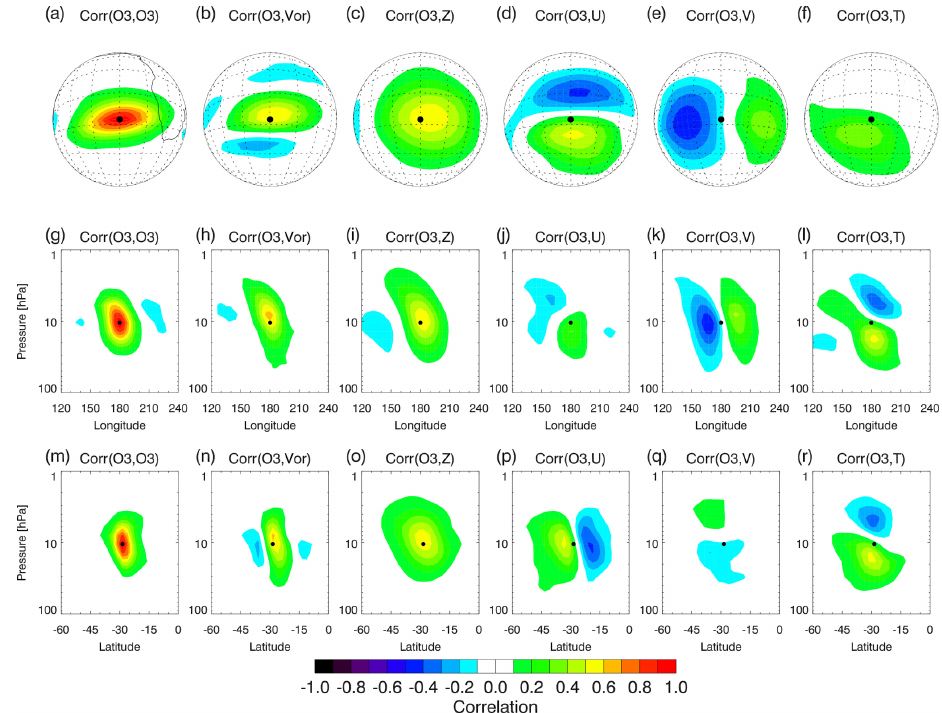
Figure 12. Composite analysis of the ensemble cross-correlations (“Corr”) between ozone and other variables on 30 November 2014 (00:00Z). Calculation is an average at 10.5hPa and latitude of 28.6 ◦ S, and the observation (black dot) is centered at 180 ◦ longitude (see text for details). Top row is the horizontal correlation using a satellite projection with grid lines at 10 ◦ spacing in longitude and latitude, and continental outline is shown for southern Africa in panel (a) . The middle row is the longitude–pressure cross section, and bottom row is the latitude–pressure cross section. Columns indicate correlation between ozone and (1) ozone, (2) vorticity, (3) geopotential height, (4) zonal wind, (5) meridional wind, and (6) temperature. Colors are correlation with red (blue) indicating high (low)